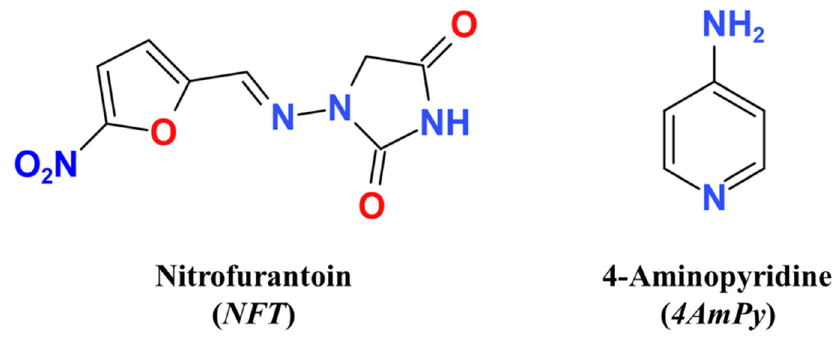
Figure 1. Chemical structures of nitrofurantoin and 4-aminopyridine.